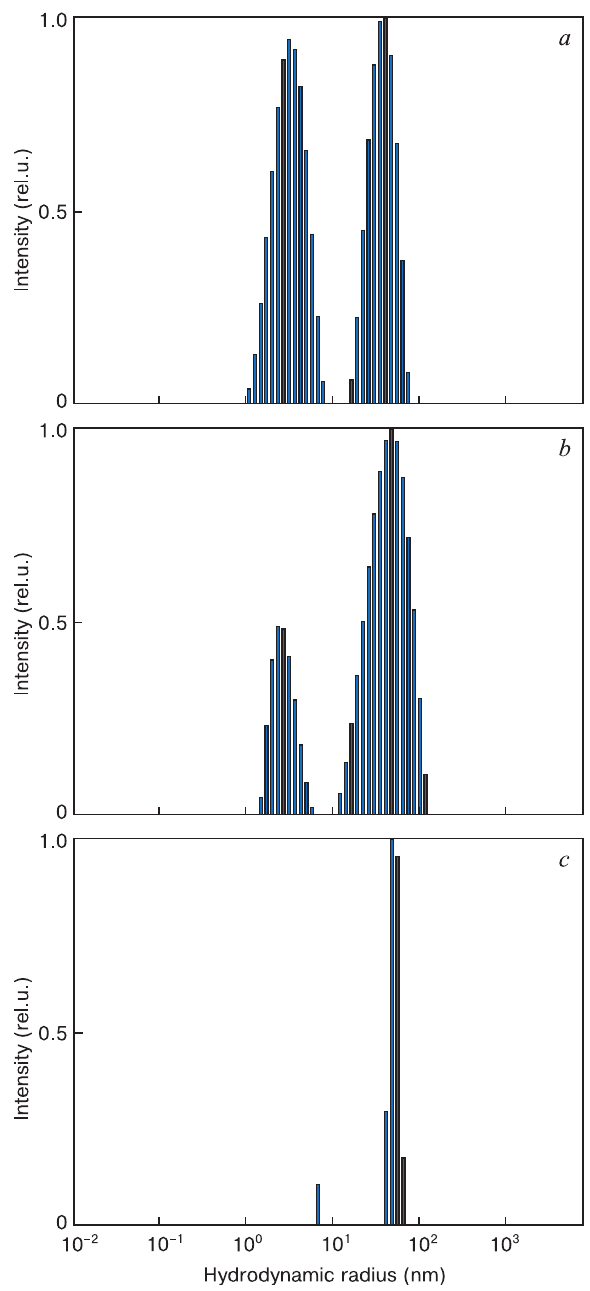
Figure 6. Scattered light intensity distributions for ( a ) disper- sion of nanorods, ( b ) compound diospersion of nanorods and nanospheres and ( c ) dispersion of